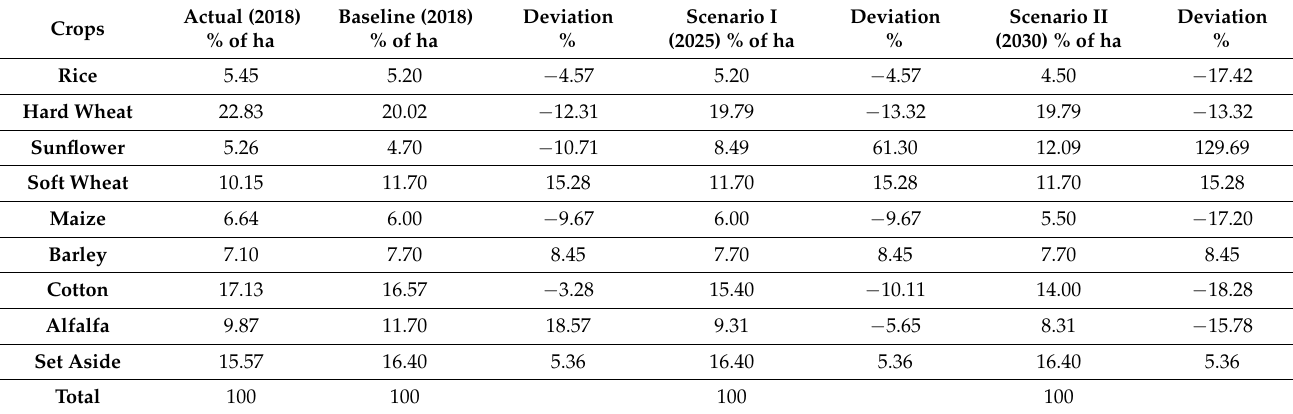
Table 5. Actual crop plan vs. optimum crop plans for baseline (2018) scenario, scenario I (2025), and scenario II (2030) (%).